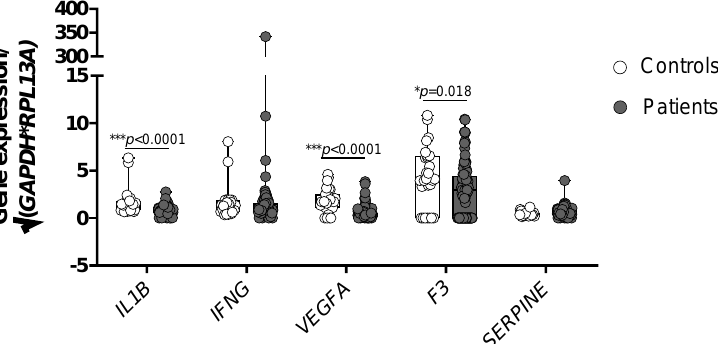
Figure 2. Comparison of the gene expression profile between healthy controls and patients with CAD. Significant differences were obtained for IL1B , VEGFA and F3 as indicated (*** p < 0.0001, * p < 0.05, Mann Whitney U test). Shown are box and whisker plots with individual values. Gene expression data are normalized to geometric mean of glyceraldehyde-3-phosphate dehydrogenase ( GAPDH ) and ribosomal protein L13a ( RPL13A ).